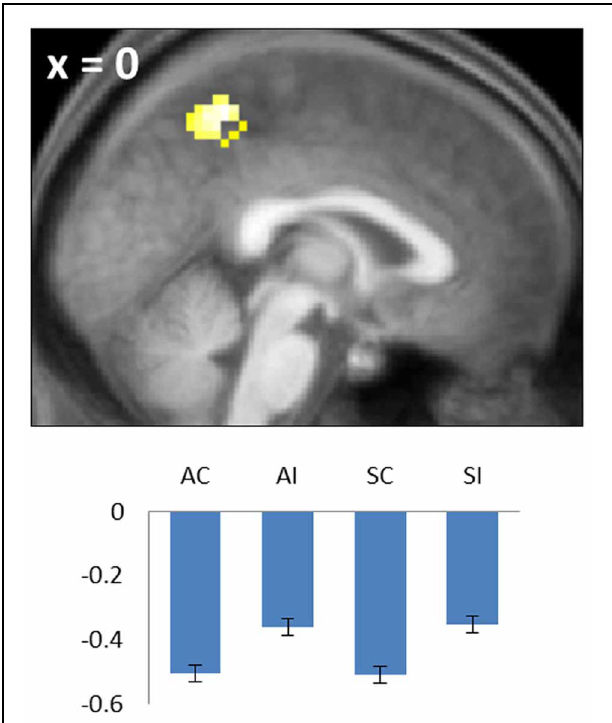
FIGURE 4 | Negative common subsequent memory effect in the medial parietal cortex (precuneus). Bar plot shows the peak parameter estimates for the four conditions of interest. Results are overlaid onto a sagittal section of the across-subjects mean T1-weighted anatomical